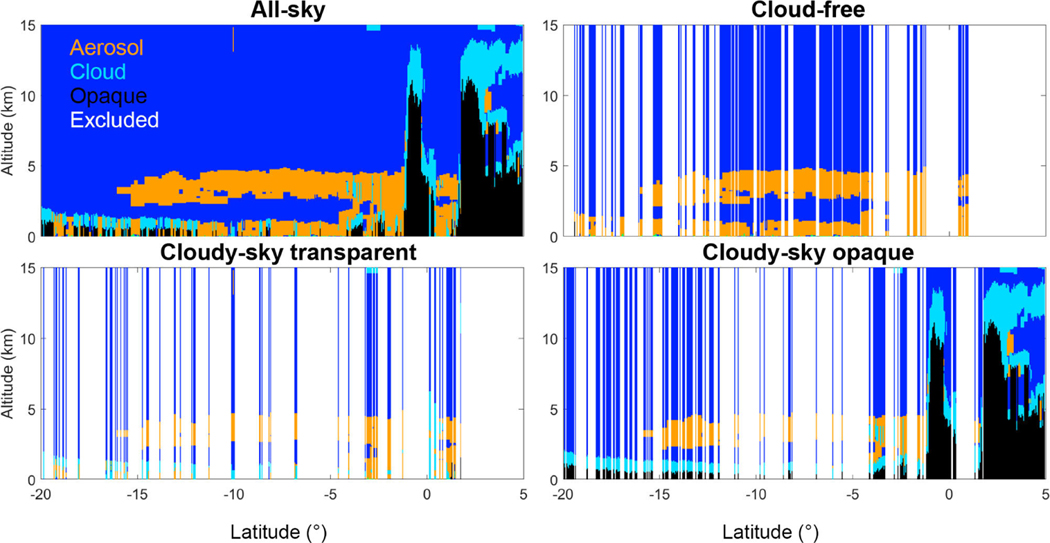
Feature classifications for an individual nighttime level 2 granule (2008–01-01T01–30-23ZN) demonstrating the four level 3 sky conditions. Data in white columns are excluded for the indicated sky condition. Clouds, aerosols and totally attenuated (opaque) features are light blue, orange, and black, respectively.